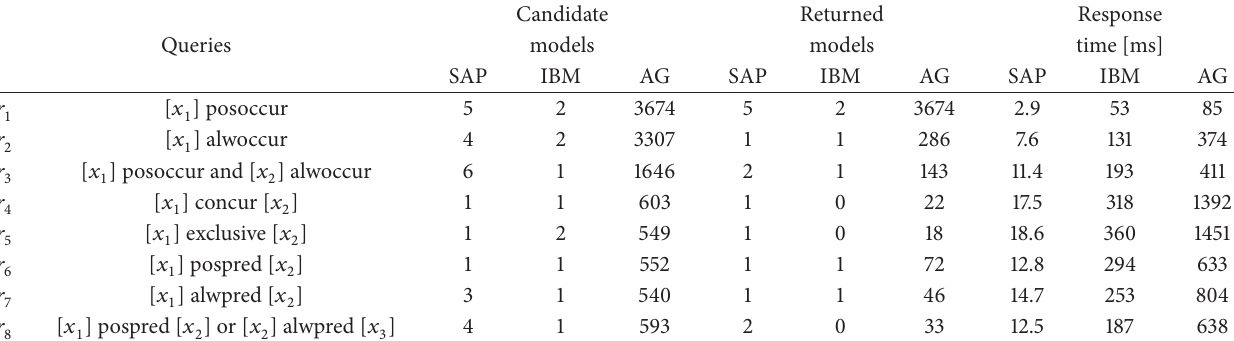
Table 3: Response times to execute eight sample compliance rules over the three